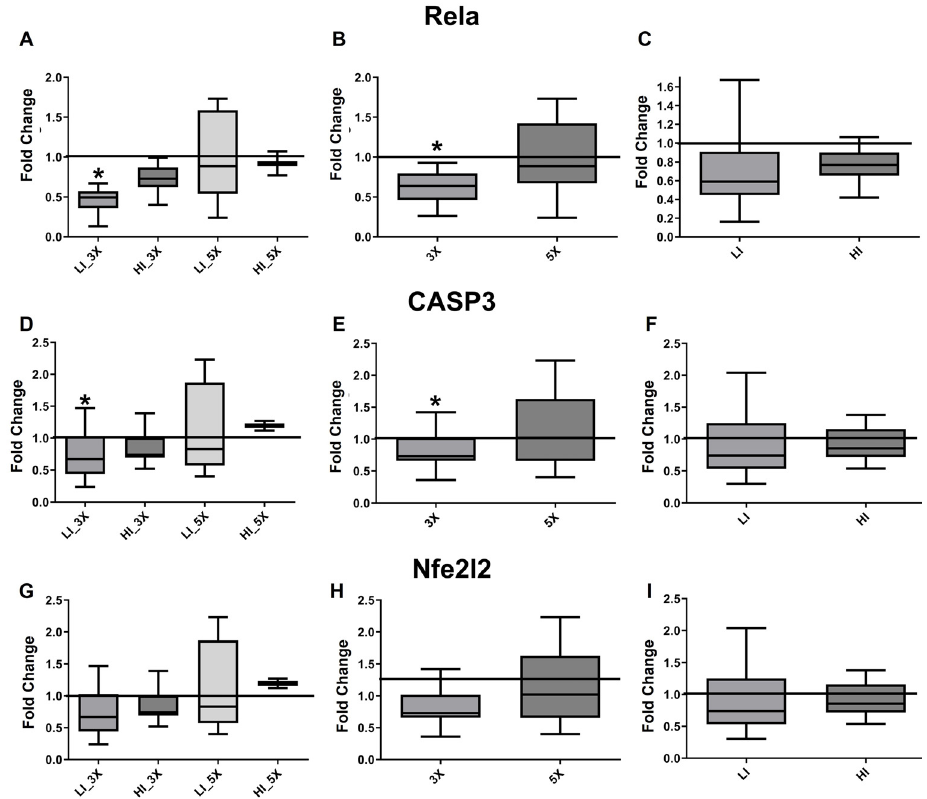
Figure 7. Median and interquartile range of gene expression of Rela (NF k B subunit p65) ( A – C ), CASP3 (caspase-3) ( D – F ), and Nfe2l2 (Nrf2) ( G – I ) from renal tissue samples after cisplatin-induced renal damage from groups (sedentary, trained at low [LI] and high [HI] intensity, three times [3X] and fi ve times [5X] per week). *P o 0.05 compared with sedentary group